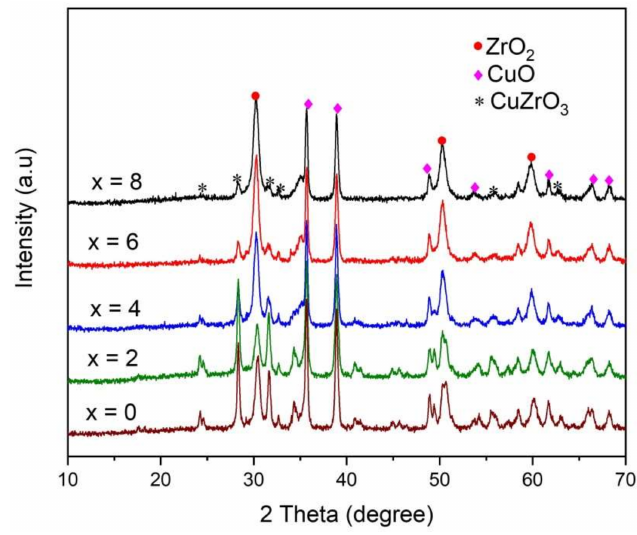
Figure 1. XRD patterns of the ZrO 2 /CuO nanocomposite powder with doping of Ce 3+ /Ce 4+ (0–8 mol%). The diffraction peaks originating at 2 θ = ~ 30.48 ◦ , 34.35 ◦ , 50.30 ◦ , 50.65 ◦ and 60.09 ◦ correspond to (101), (200), (112), (220) and (202) planes of the tetragonal phase of ZrO 2 (JCPDS No. 00–050–1089), respectively. The diffraction peaks observed at 2 θ = ~ 35.68 ◦ , 38.89 ◦ , 48.93 ◦ , 53.62 ◦ , 61.70 ◦ , 65.97 ◦ and 68.20 ◦ are associated with (002), (111), ( − 202), (020), ( − 113), (022) and (113) planes, signifying the monoclinic phase of CuO (JCPDS No.